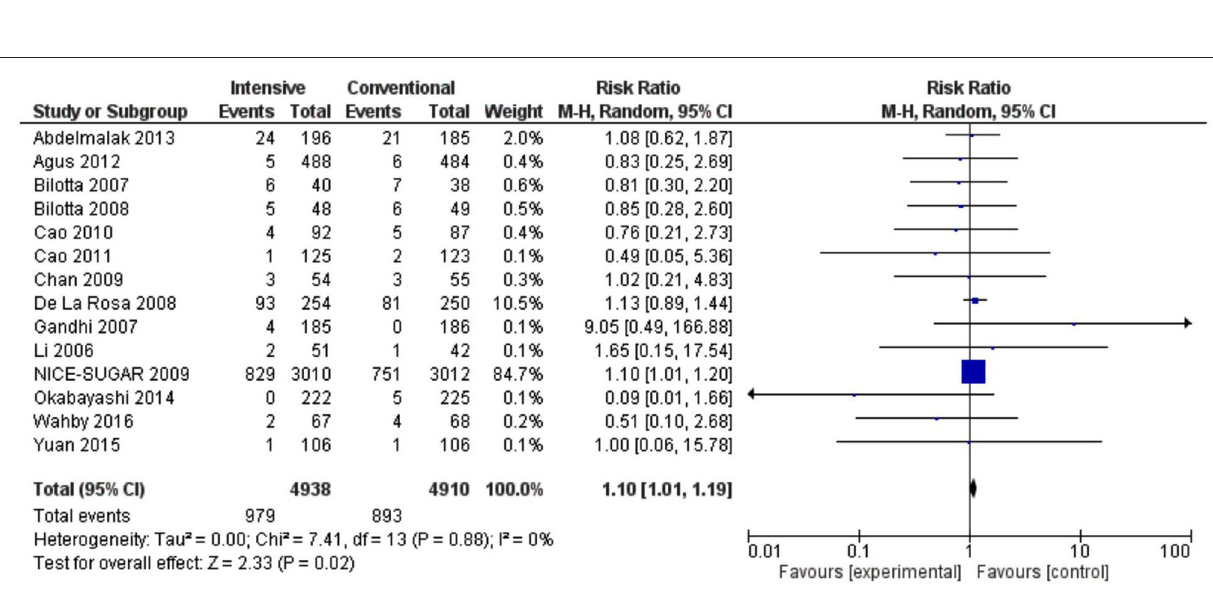
FIGURE 9 | Forest plot of mortality outcome for studies using a random-effects model. RRs and 95% CIs are shown. Experimental: intensive, control: